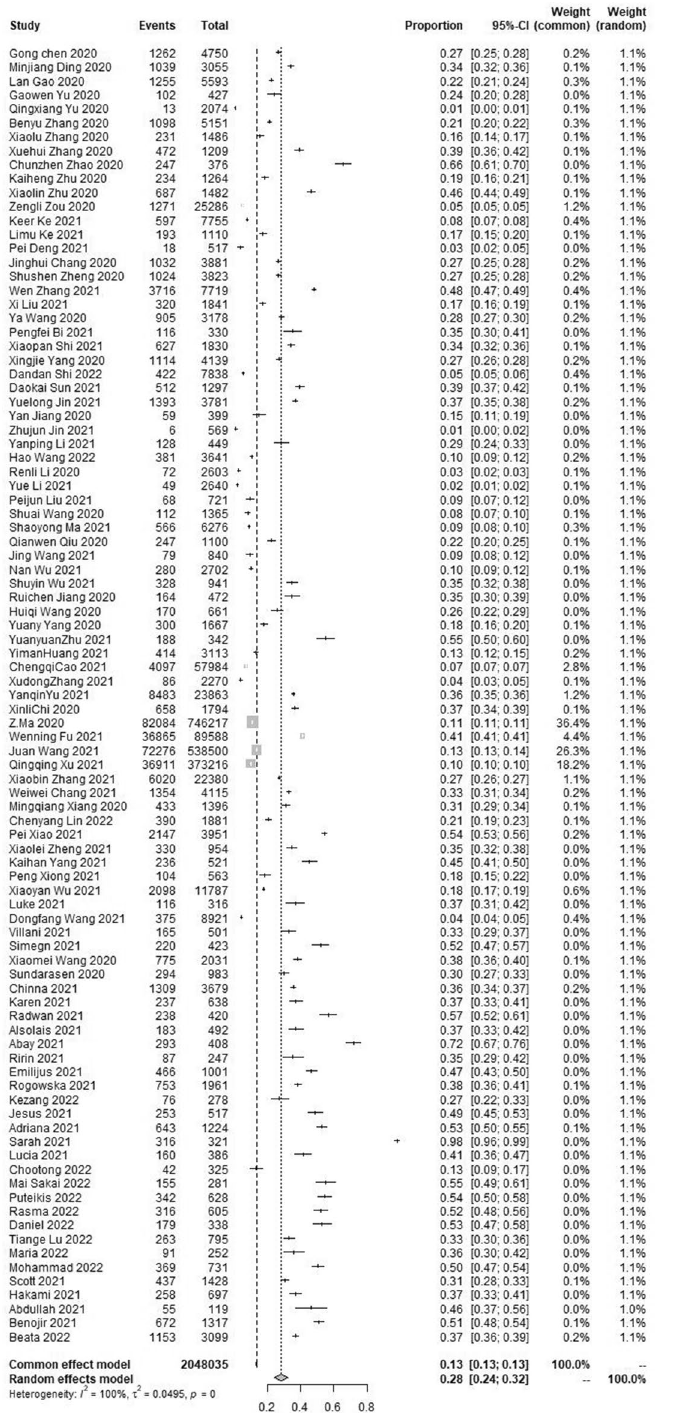
Figure 3. Forest plot of the meta-analysis on prevalence rates of anxiety symptoms in the student